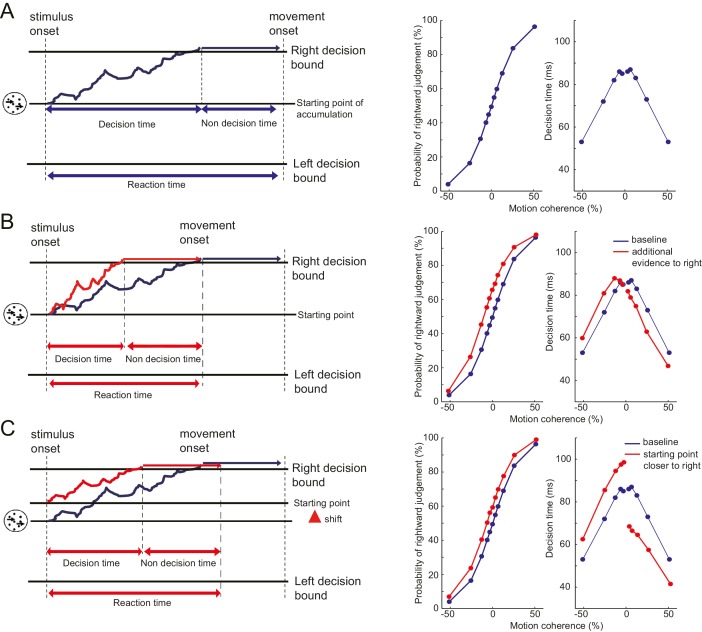
Schematic diagram explaining the drift diffusion model (DDM) and the simulated choice and decision time data.(A) DDM model postulates that a decision is transformed into action when the evidence favouring one of the choices has been accumulated to a certain threshold level (decision bound) (left panel). The model makes a prediction about the pattern of choice probability and the decision time in respect to the strength of the motion signal (right panel). For the baseline, the starting point of the evidence accumulation is set to 0. (B) When there is more sensory evidence in favour of rightward motion (red line), the drift speed for the rightward decision will increase (left panel), and left would decrease. As a result, a rightward decision becomes more likely (shift of psychometric function) and the decision time pattern generally shifts to the left, showing a tendency to respond faster for the rightward motion (right panel). If the motor cost influences the sensory representation (Figure 2C), we would expect this pattern of results (sensory representation model). (C) A shift in the starting value of the accumulation process induces a prior bias towards a rightward decision, decreasing the required amount of evidence for rightward decision compared to the left (left panel). This will again bias the decision to favour the rightward decision. Instead of shifting the pattern of decision times to the left (as in B), the starting point model predicts an additional offset to the rightward and leftward decision time; shorter for the rightward decision and longer for the leftward decision. In this model, the bias therefore arises from a change in the decision layer transforming the sensory representation into the decision (Figure 2B), while the sensory evidence itself is not changing.